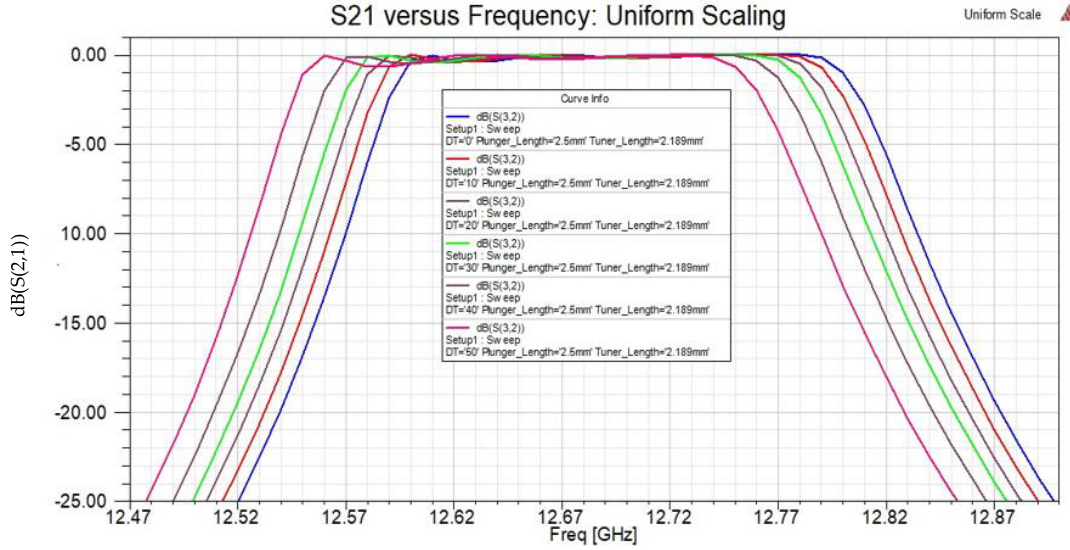
Figure 12. Bandpass filter scaling in HFSS ΔT = 0–50 °C.